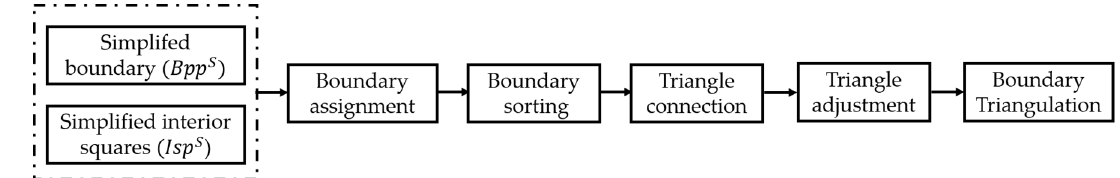
Figure 6. Flow chart of vertex-assignment triangulation.